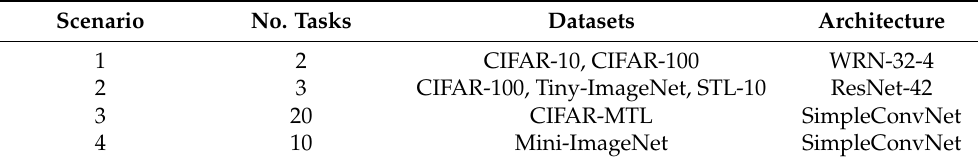
Table 2. Summary of four experimental scenarios with the corresponding architectures.